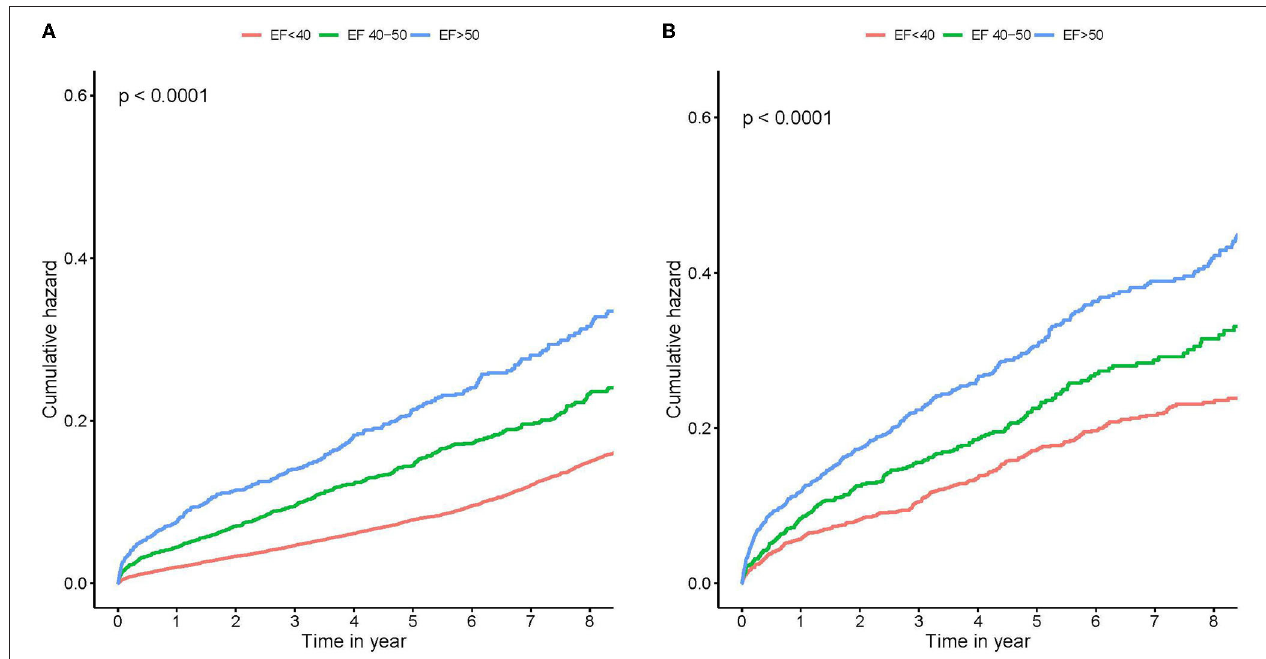
FIGURE 1 | Kaplan–Meier survival curves stratified by left ventricular ejection fraction (LVEF). Survival stratified by LVEF < 40, 40 to 50%, and ≥ 50% throughout none or mild MR (A) , and moderate or severe MR (B) . Note the large mortality difference between different LVEF groups. MR, mitral regurgitation.